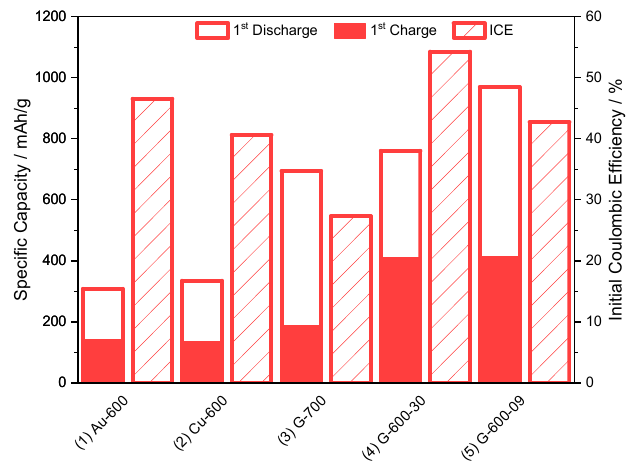
Figure 3. Electrochemical performance summary of selected cells, with the 1st discharge and charge capacities when cycled at 10 mA/g against Na/Na+, and the initial coulombic efficiency of the 1st charge cycle (striped bars).